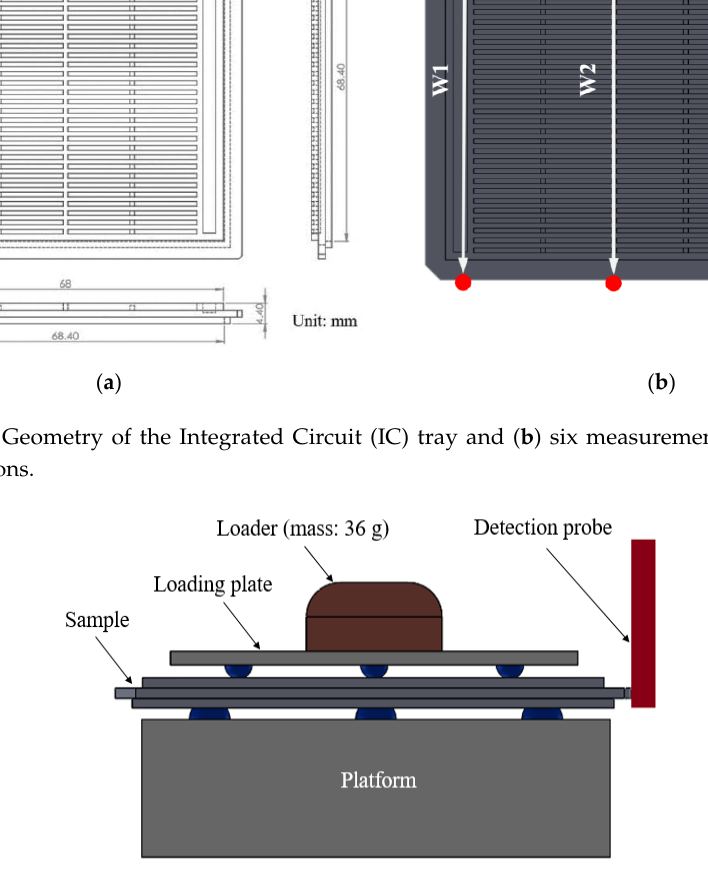
Figure 7. Schematic of the MLP inspection system. 3.1. Injection Machine, Material, Mold and Sensor To produce IC trays, this study used an all-electric-driven injection molding machine with a clamping force of 100 tons (CT-100, Fu-Chun Shin Corporation, Tainan, Taiwan). The polymer material used was acrylonitrile–butadiene–styrene (PA-756 Chi-Mei Corporation, Tainan, Taiwan).